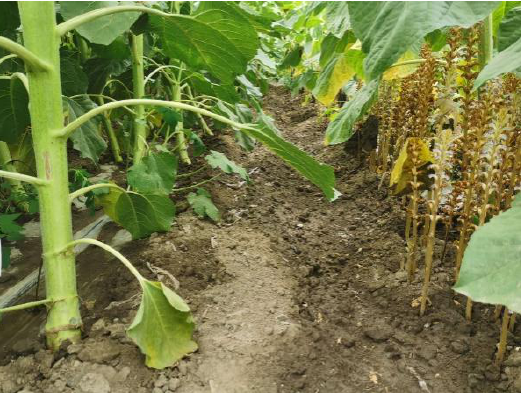
Figure 2. O. cumana parasitism of HZ2399 and SQ25 in the field. The picture on the left is HZ2399; the picture on the right is SQ25.